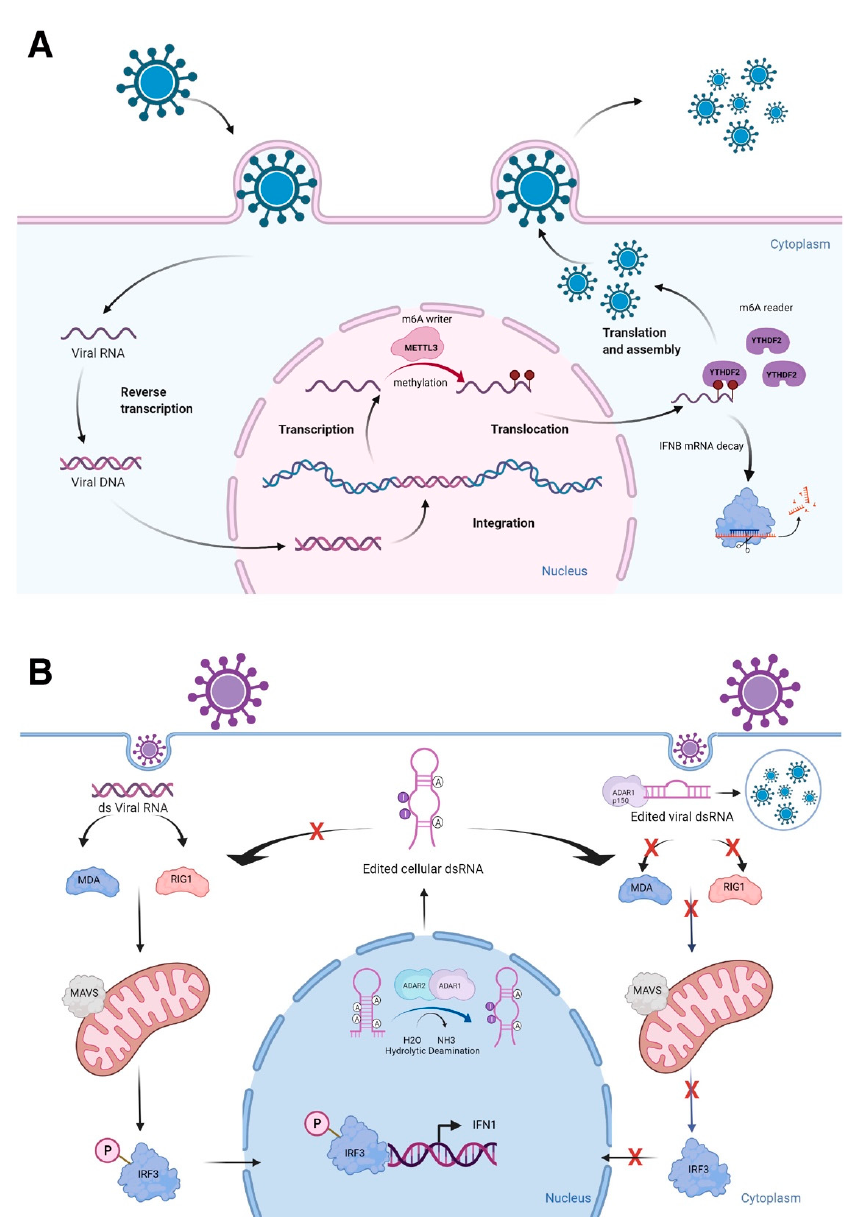
Figure 1. Epitranscriptomic marks and RNA structures in immune responses. ( A ) Viral RNA meth-